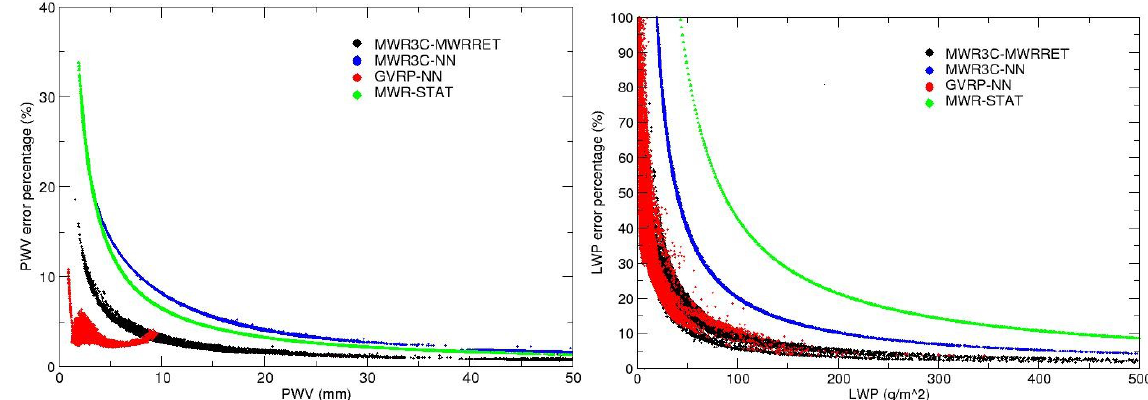
Fig. 13. Errors in the PWV (left panel) and LWP (right panel) retrievals resulting from various combinations of channels and algorithms. MWR3C (22.834, 30, 90GHz) with a physical algorithm (MWRRET, black), and a neural network algorithm (NN, blue). MWR (22.8, 31.4GHz) with a statistical algorithm (STAT, green), and GVRP (170–183GHz) with neural network (NN, red).